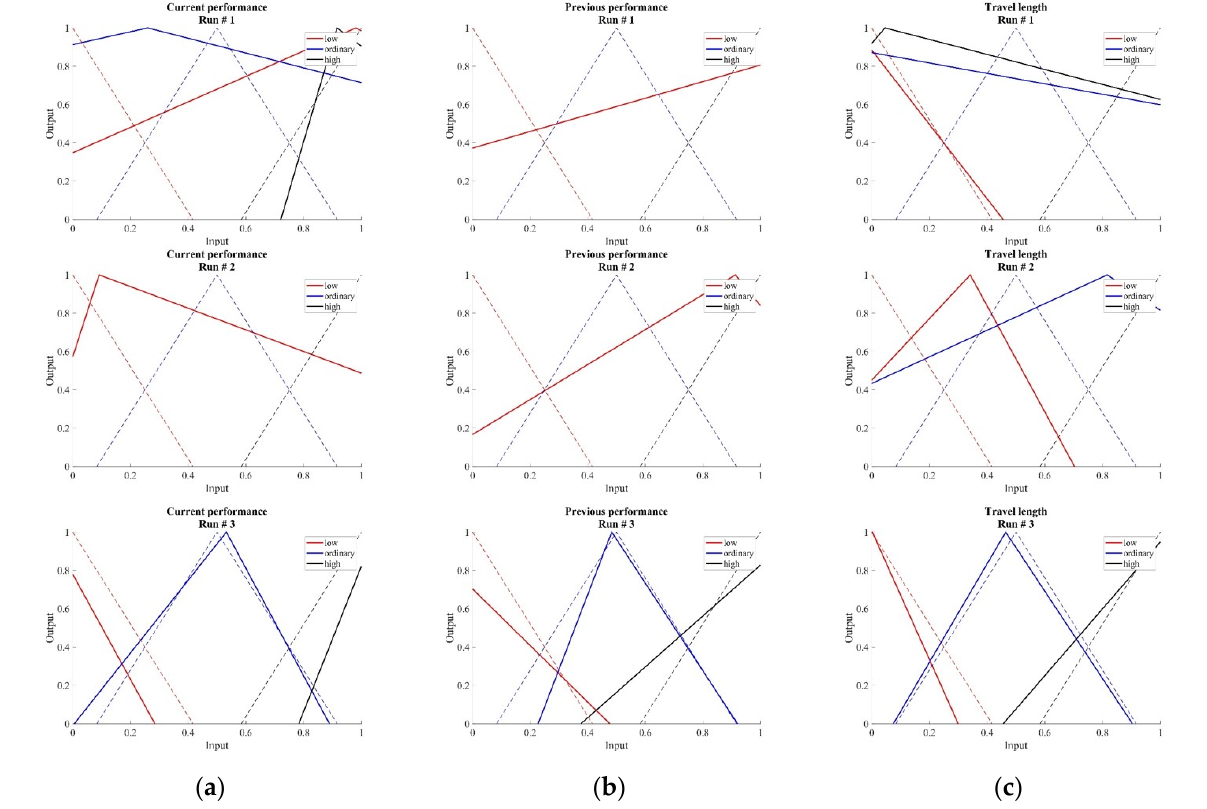
Figure 28. Optimised membership functions (MFs) of the different input variables current perfor- mance ( a ), previous performance ( b ), and travel distance ( c ) for the different optimisation runs.